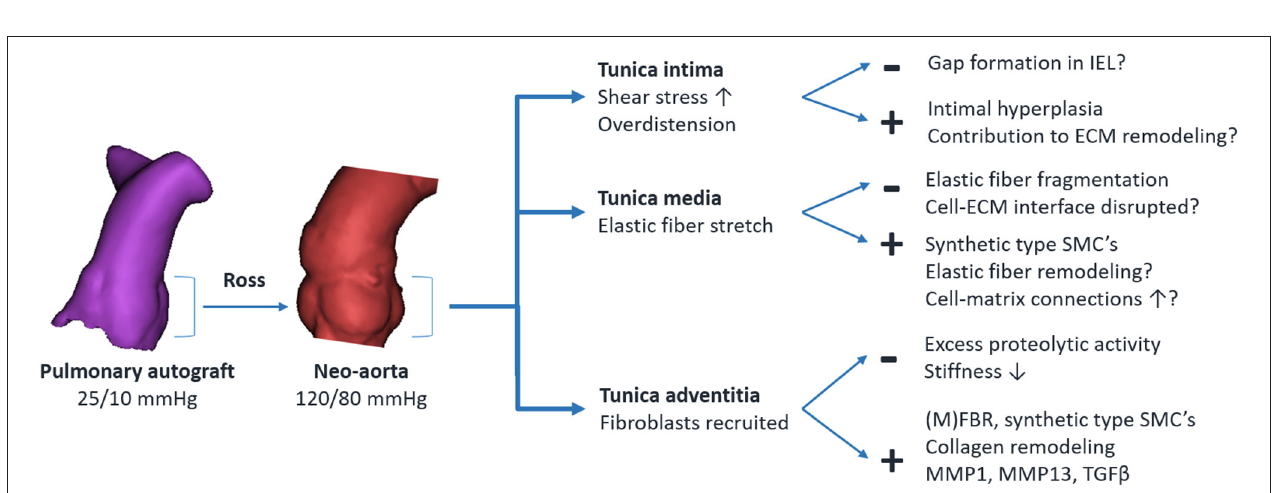
FIGURE 6 | Representative longitudinal sections through the sinus and leaflets of the pulmonary artery and aorta of a sheep weighing 60kg. Also shown are the pulmonary autograft and homograft at 6 months post-operatively in a sheep who underwent the Ross procedure (weighing 43kg at operation). Neo-vascularization in the base of the pulmonary autograft leaflet (white arrowhead) and added collagen on the adventitial side of the sinus wall (black arrowhead). The arterial wall and leaflet of the pulmonary homograft are thin and acellular. Elastica Von Gieson staining. Adapted with permission from Van Hoof et al. ( 123).